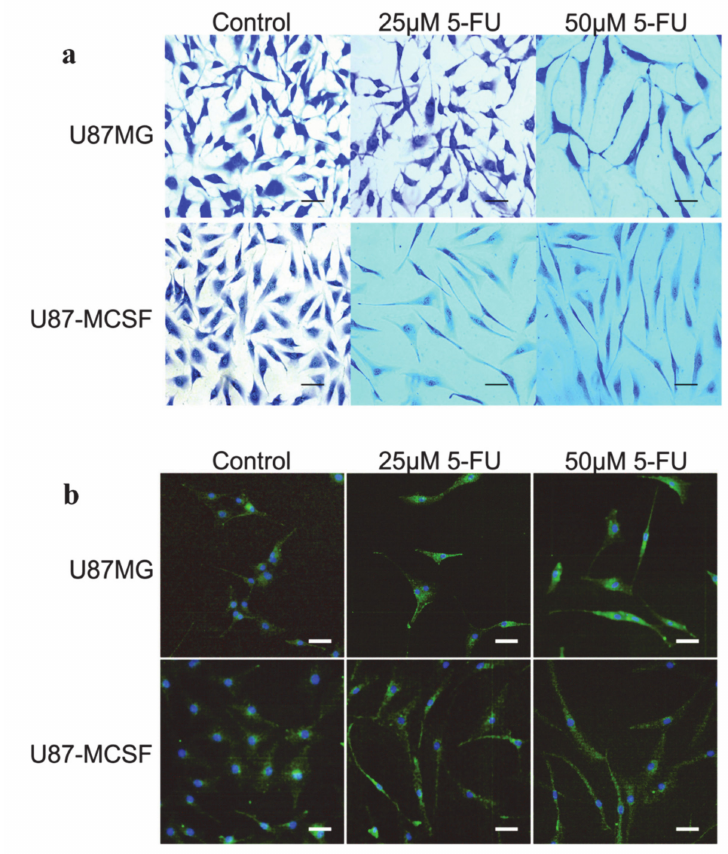
Figure 3. Microscopic examination of morphology of cells after 72 h of 5-fluorouracil (5-FU) treatment. ( a ) Methylene blue staining for detection of cell morphology after 5-FU treatment. ( b ) Actin cytoskeleton staining of treated cells using anti β -actin antibody. The morphological pictures show the presence of elongated and mesenchymal cells in U87-MCSF cells treated with 25 µ M 5-FU but not in U87MG cells treated with 25 µ M 5-FU. Upon 50 µ M 5-FU treatment, elongated cells were seen in both treated U87MG and treated U87-MCSF cells. Scale bar: 50 µ m. Reproduced with permission from